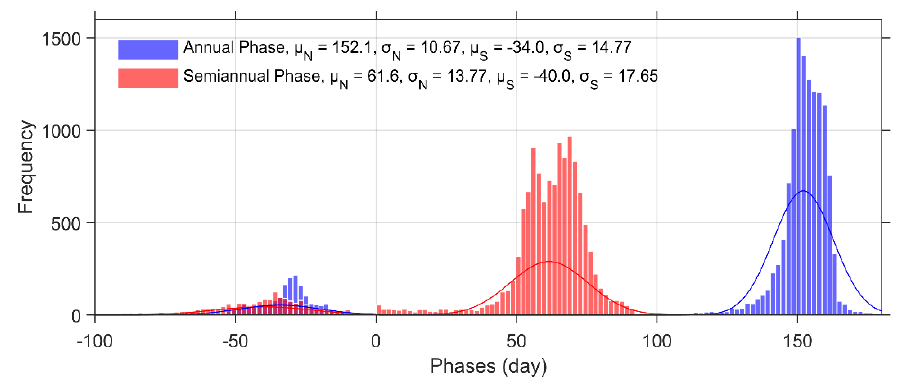
Figure 8. Statistical histogram and normal fitting of the annual phase (blue) and semiannual phase (red) in the Northern and Southern Hemispheres. The phase in the Southern Hemisphere was less than zero, the phase in the Northern Hemisphere was greater than zero, and the subscripts N and S represent the Northern and Southern Hemispheres, respectively.